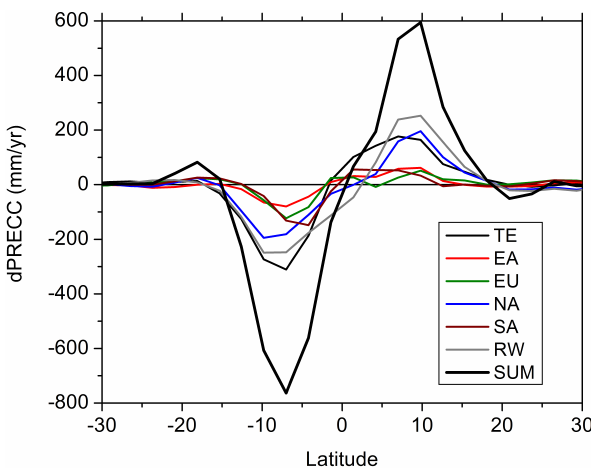
Fig. 3. Zonal means of changes in convective precipitation (mm/year) caused by BC derived from each model run. Data shown are year 41–60